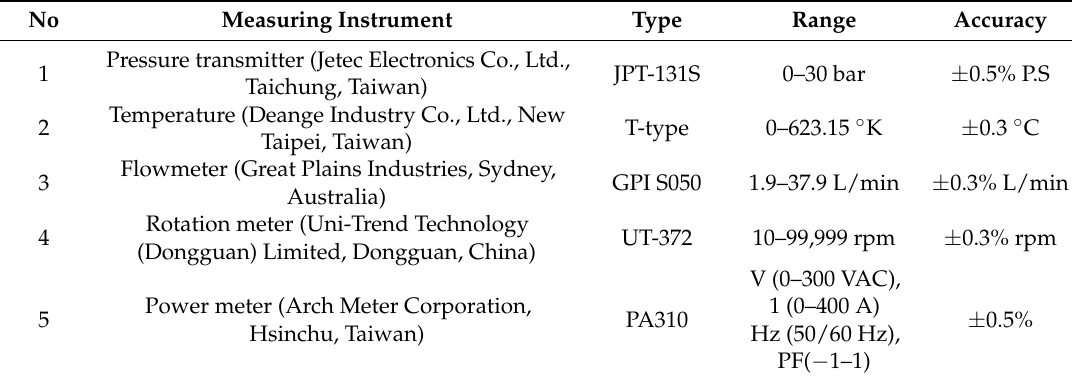
Table 1. Accuracy of measuring